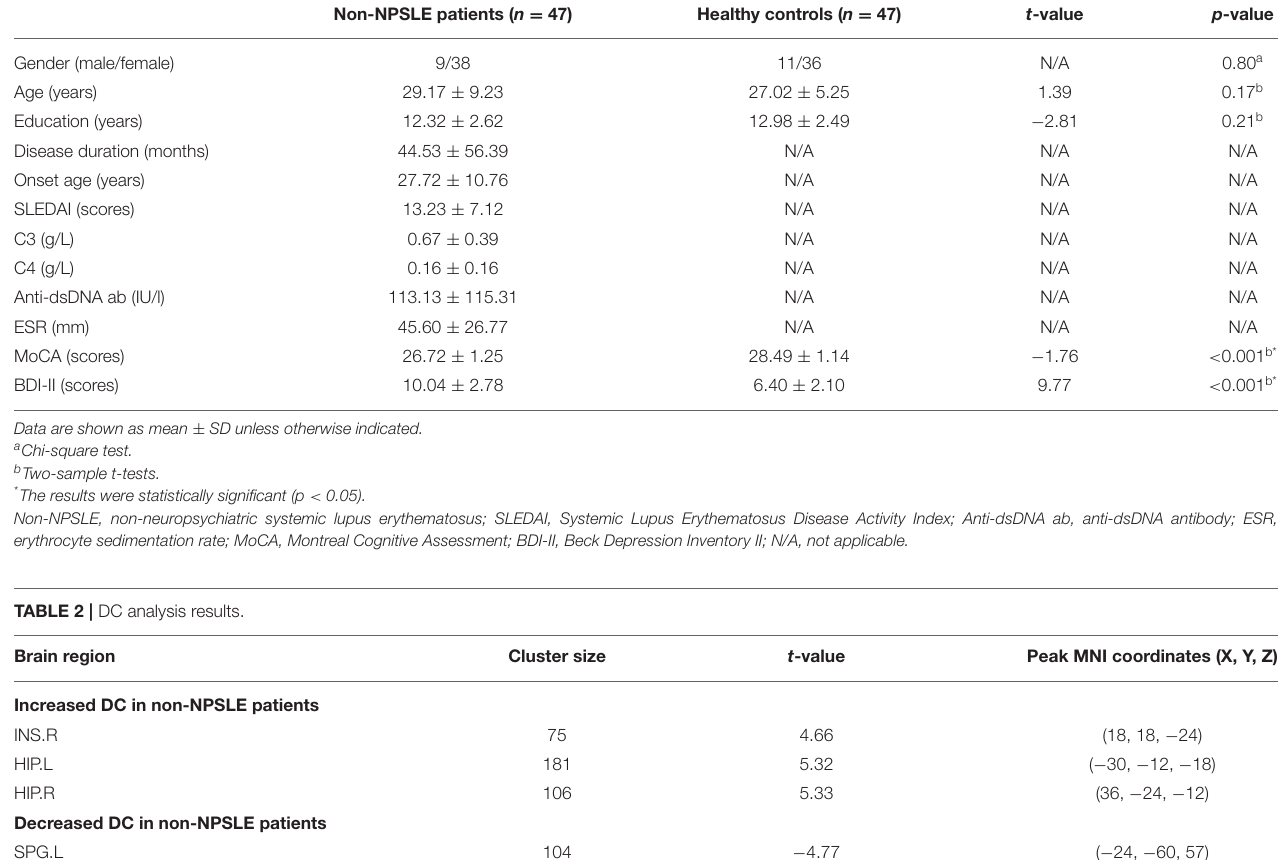
TABLE 1 | Demographics, clinical data, and neuropsychological test scores of non-NPSLE patients and healthy controls. Non-NPSLE patients ( n = 47)